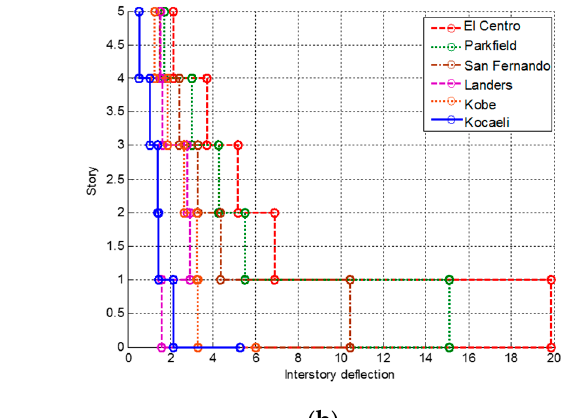
Figure 15. Plan of the building showing locations of rubber bumpers.